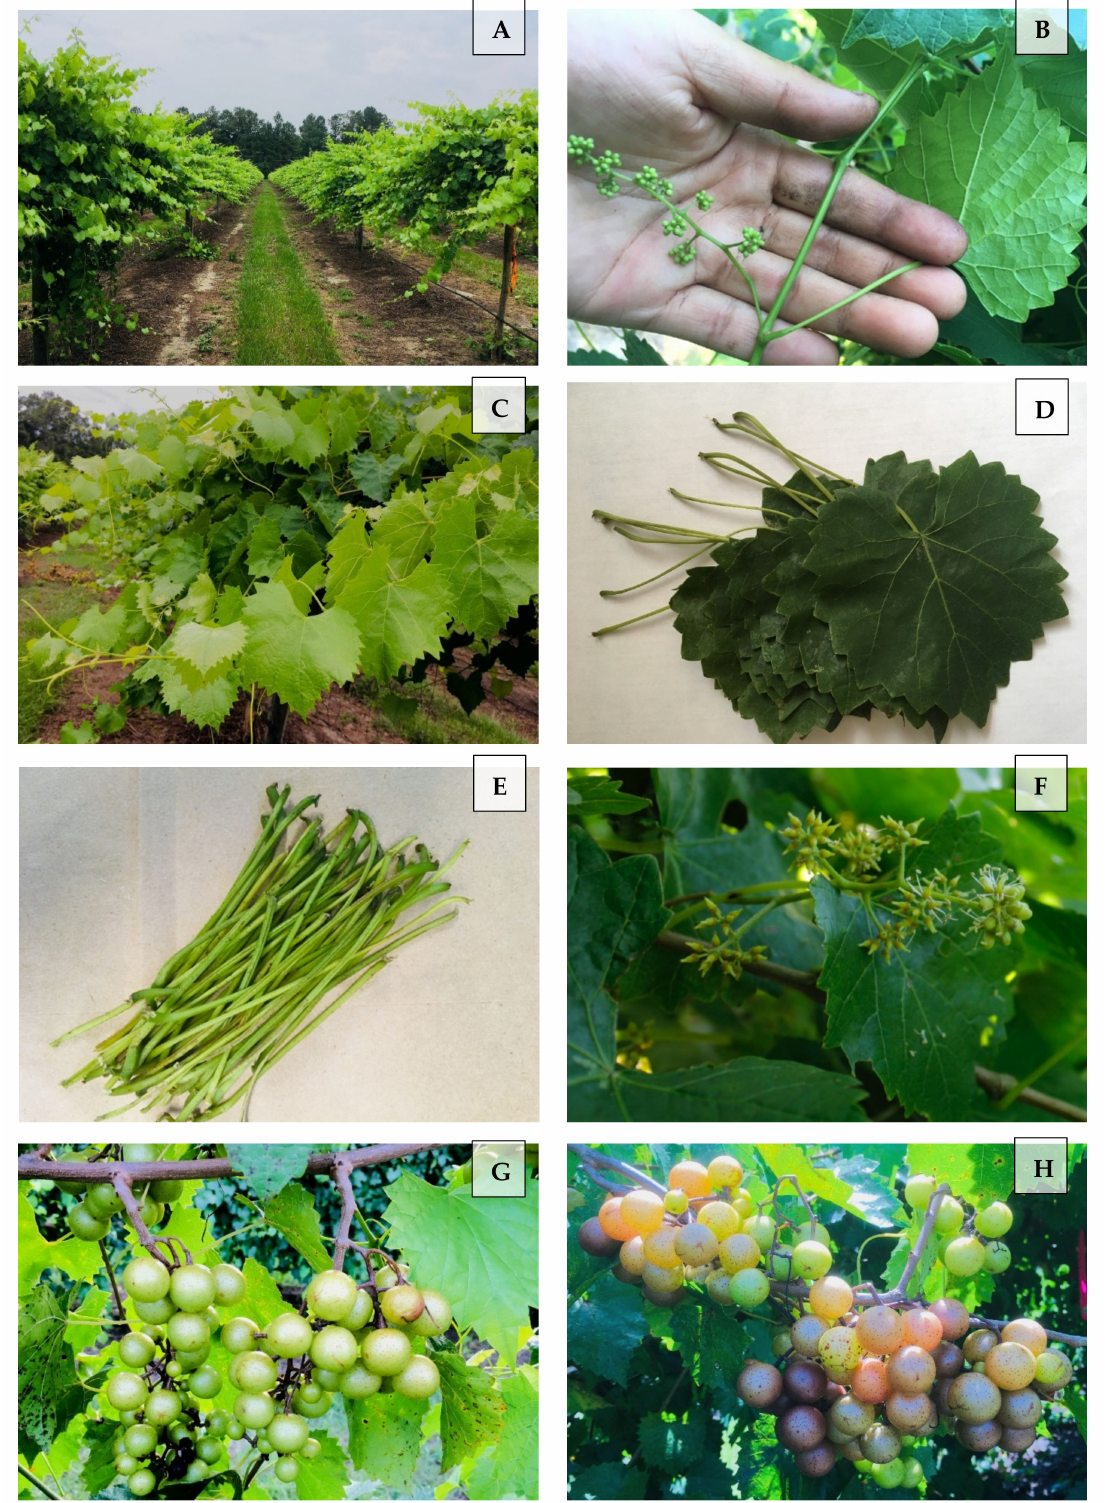
Figure 1. A commercial muscadine vineyard ( A ). Muscadines are commonly planted at 3.3 m row width and 6.6 m plant spacing on a single high wire trellis system (~1.8 m above the ground). Tissue sampling positions: opposite to cluster ( B ) and first fully mature leaf ( C ). Tissue types: full leaf ( D ) and petioles ( E ). Growth stages: late bloom—early fruit set ( F ), late fruit set ( G ), and mid v é raison ( H